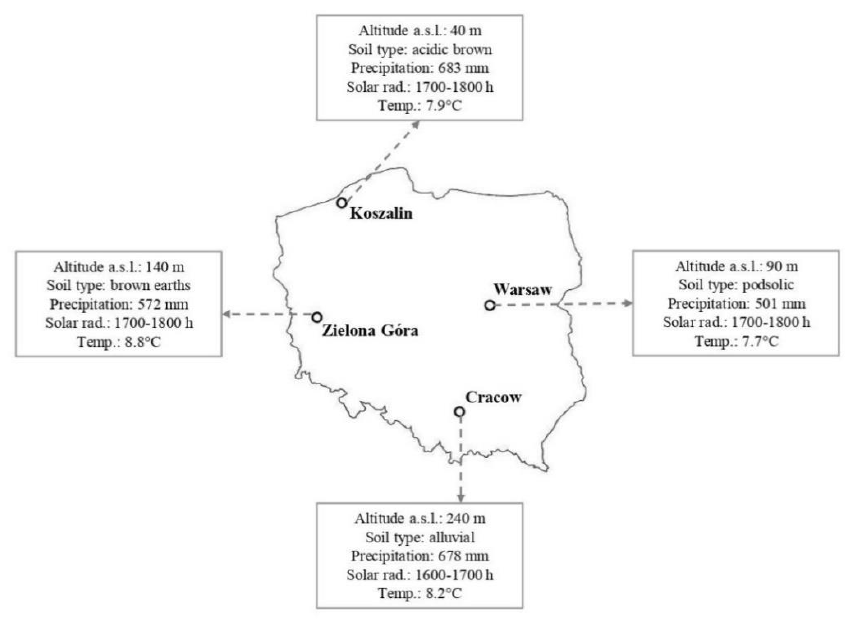
Figure 1. Location and main environmental parameters of collection sites of Taxus baccata red berries in Poland.